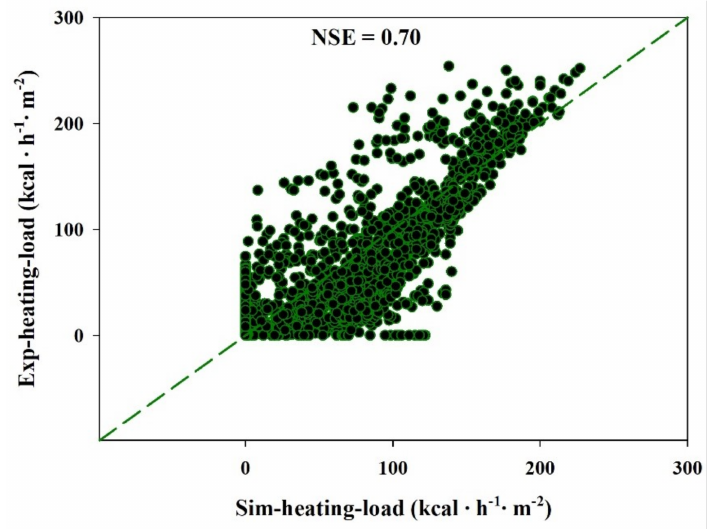
Figure 12. Statistical analysis of measured vs. computed heating supplied from water storage tank to greenhouse.